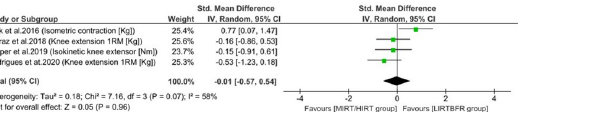
Fig 2. Forest plot of the comparison between LIRTBFR, MIRT and HIRT on muscle strength assessed by specific tests for quadriceps strength (n = 4 studies). LIRTBFR: Low intensity resistance training combined with blood flow restriction; MIRT: Moderate intensity resistance training; HIRT: High intensity resistance training; 1RM: 1 maximum repetition; Kg: kilogram; Nm: Newton-meter; I 2 : Heterogeneity of studies; SD: standard deviation; MD: mean difference; SMD: standardized mean difference; 95% CI: 95% confidence interval; IV: inverse variance; Random: random effects model.